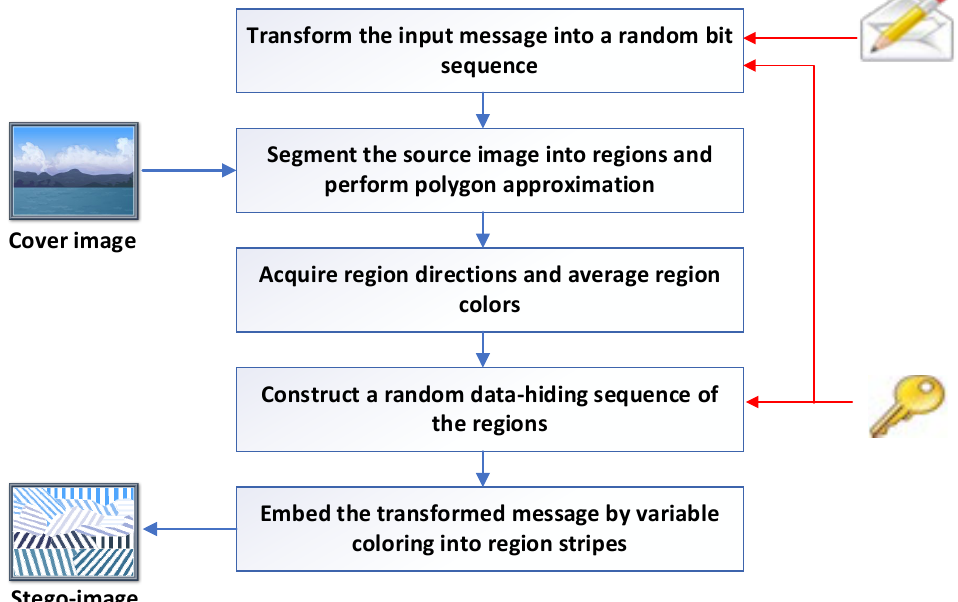
Figure 12. A flowchart of the proposed data embedding